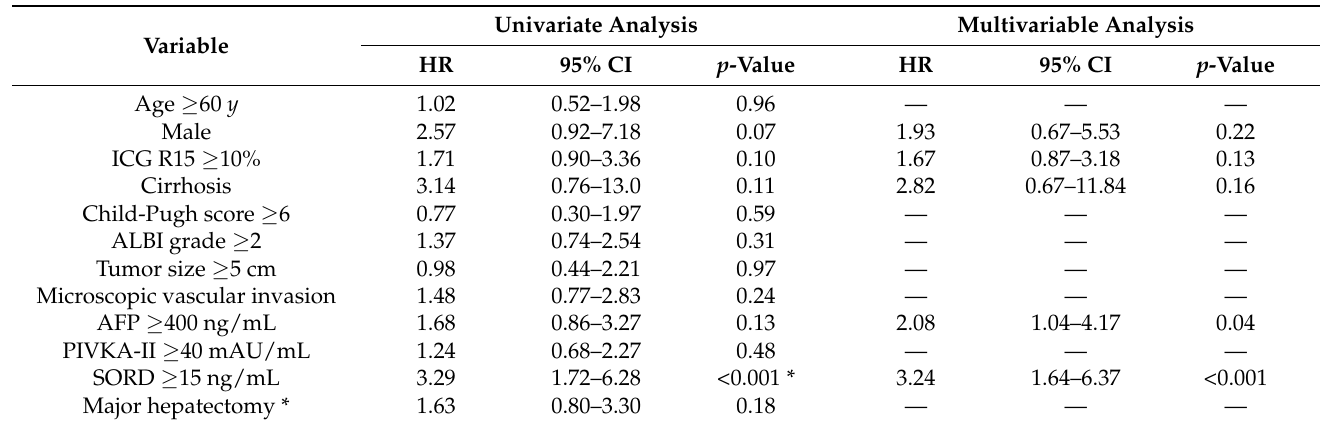
Table 2. Univariate and multivariable analyses for recurrence-free survival. Variable